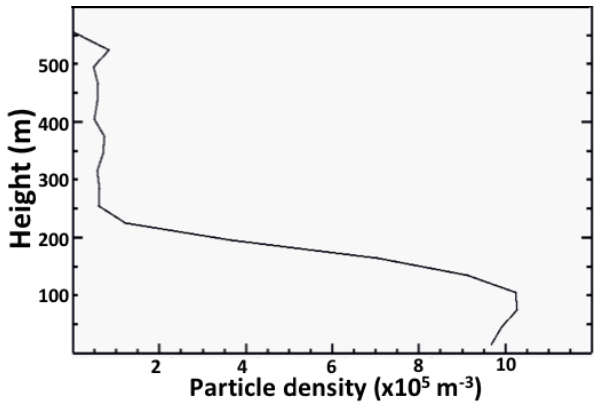
Figure 2. Average particle density profile (Eq. 3) through the blow- ing snow layer shown in Fig.